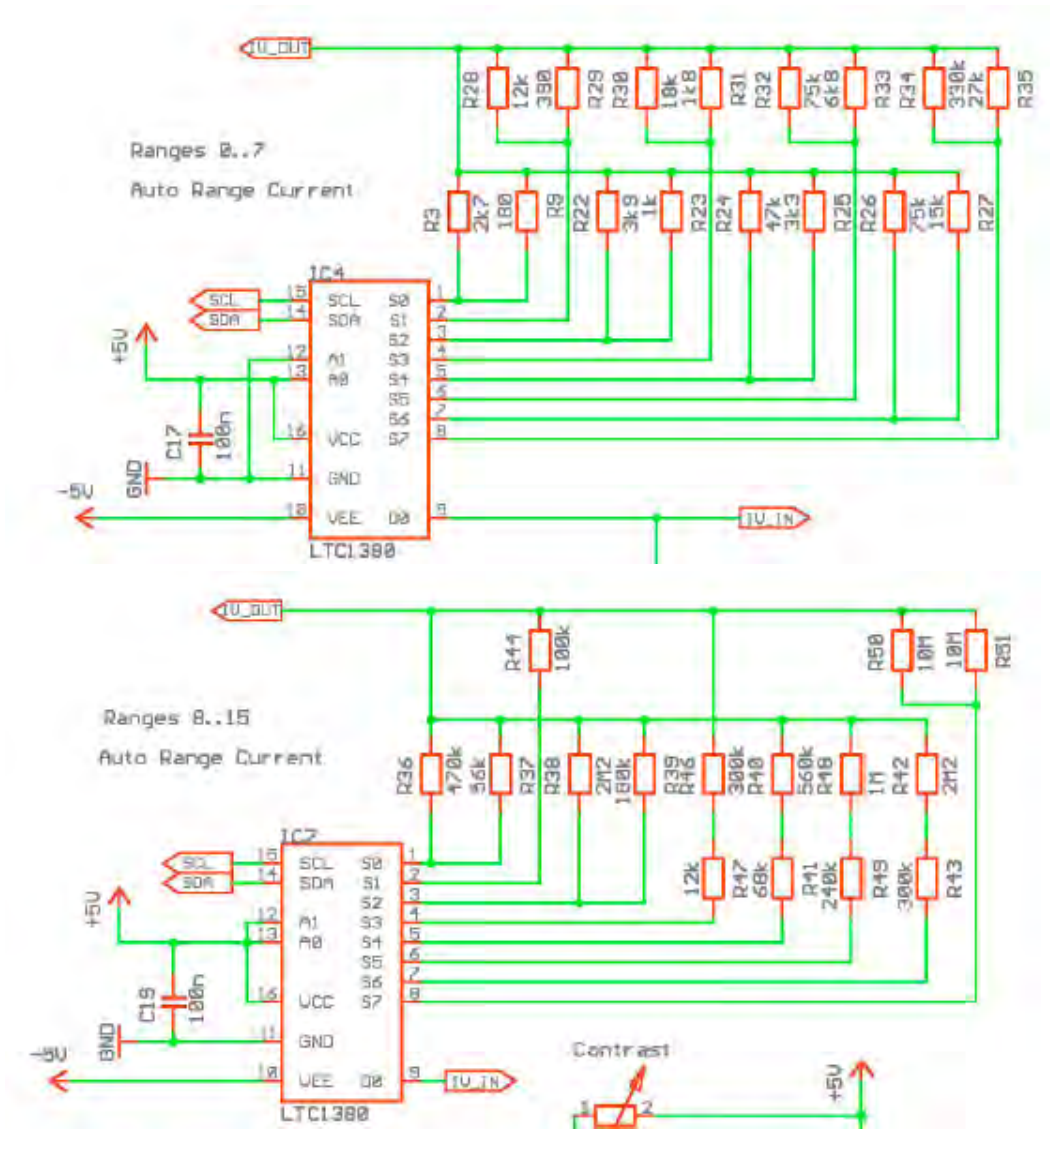
Figure 7. The Hardware used to implement the Autoranging